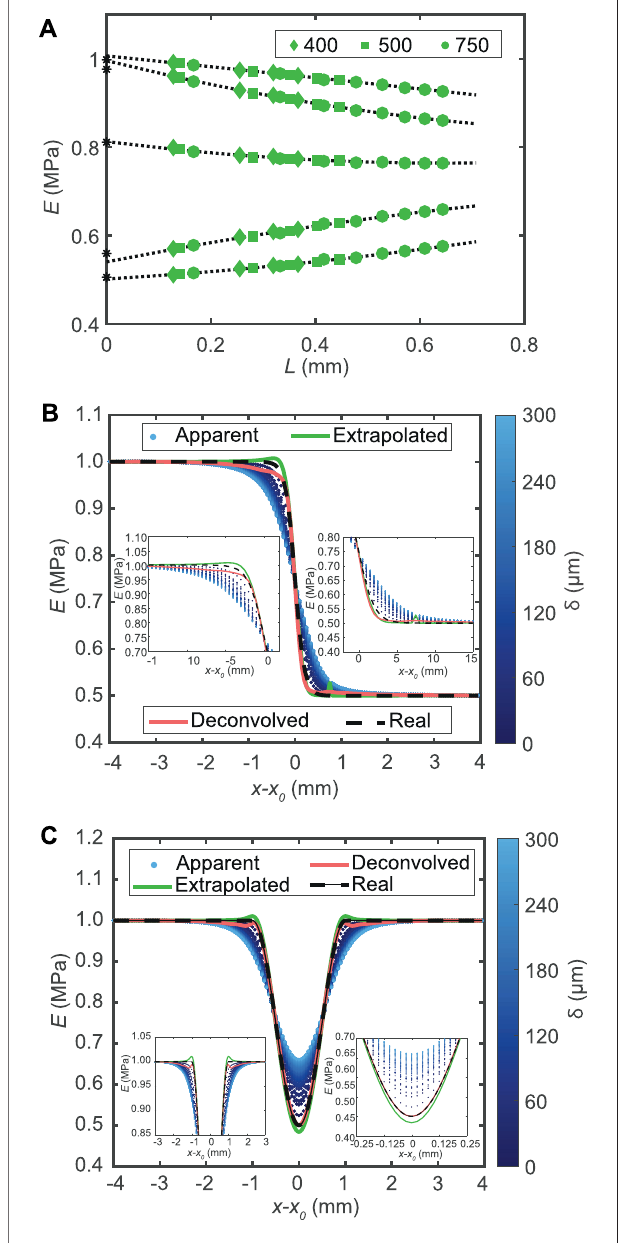
FIGURE5|(A) E a plotted versus the L for all three radii simulated for a sigmoidal pro fi le with width w (cid:1) 10 mm. The data are extrapolated using a second order polynomial fi t to give an extrapolated modulus E e at L (cid:1) 0, indicated with an asterisk (*), which approximates the local E . The legend shows the symbols corresponding to R . For visualization purpose, every eighth data point is plotted. (B) Elastic moduli plotted versus indentation position around the center of the pro fi le. Insets are zoom-ins. Note that the data shown in both panel (A) and (B) are from a sigmoidal pro fi le with w (cid:1) 10.0 mm. (C) Elastic moduli plotted as a function of indentation position for the 1D well pro fi les for w (cid:1) 2.0 mm, with δ color coded. Insets are zoom-ins.